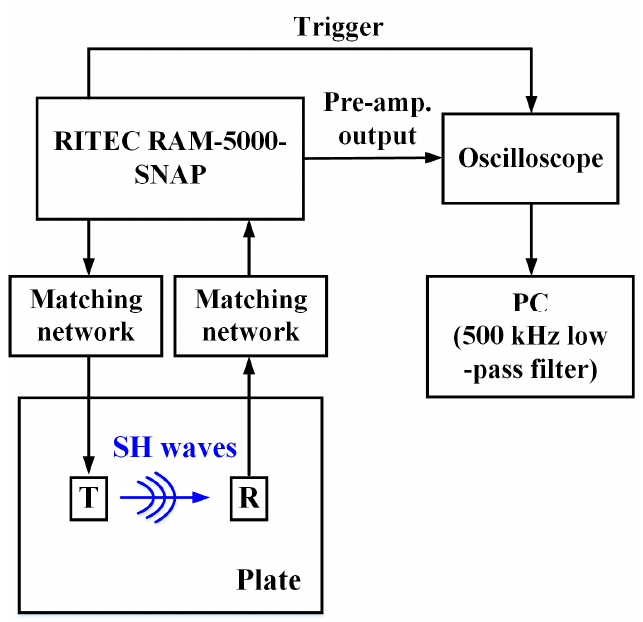
Figure 7. Schematic of the experimental setup for measuring SH waves using EMATs and MSTs.